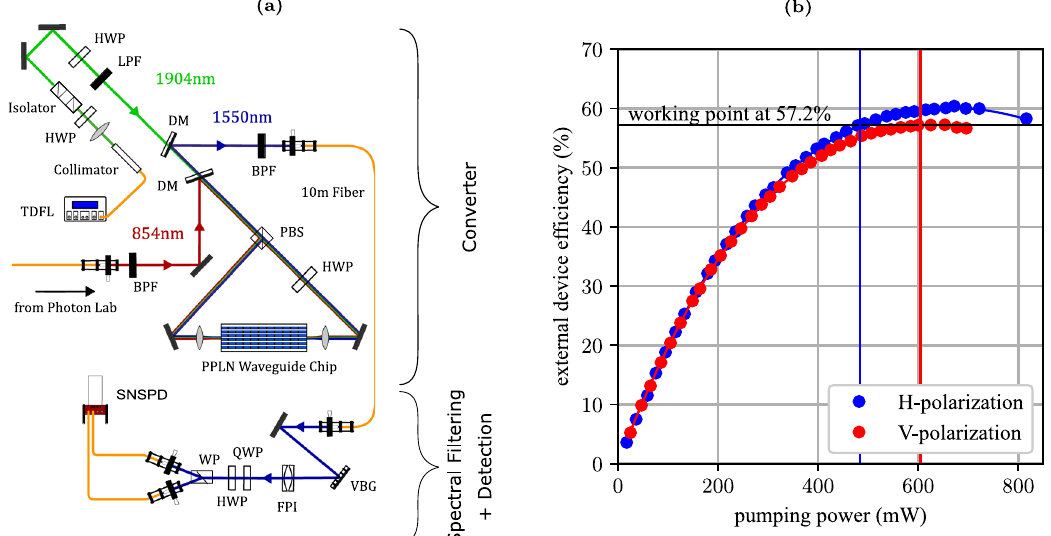
Fig. 4 Quantum frequency converter. a Schematic quantum frequency conversion setup. Details are found in the main text. TDFL thulium- doped fi ber laser, LPF low-pass fi lter, BPF band-pass fi lter, VBG volume-Bragg grating, DM dichroic mirror, HWP half-wave plate, SNSPD superconducting nanowire single-photon detector; b Device ef fi ciency of the converter for different pump powers and input polarizations. The maximum ef fi ciencies of the H- and V-polarizations are slightly